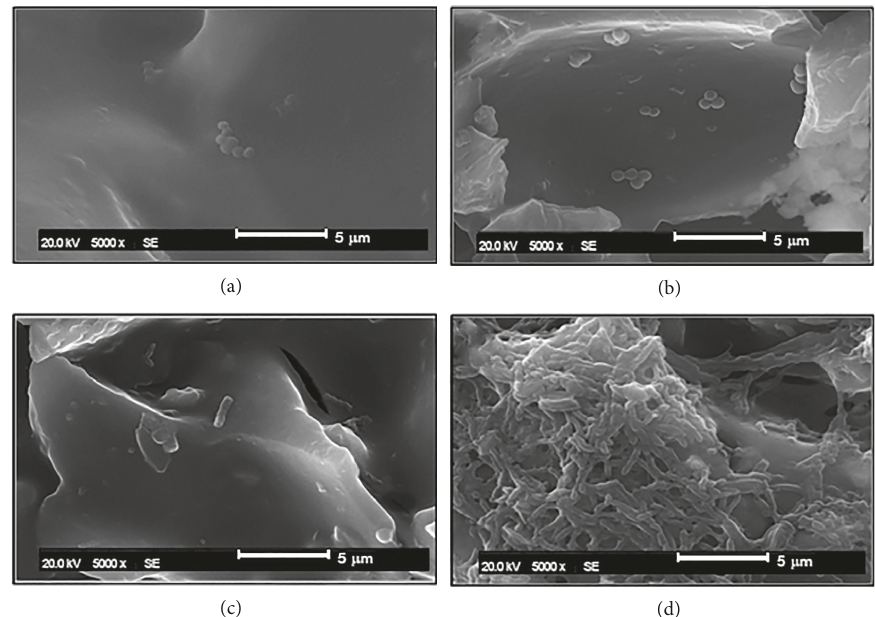
Figure 4: Bioanodes morphology with different configurations. (a) S +AB7 + E . coli , (b) S +AB7-f + E . coli , (c) S +AB7+ B . subtilis , and (d) S +AB7-f + B . subtilis .